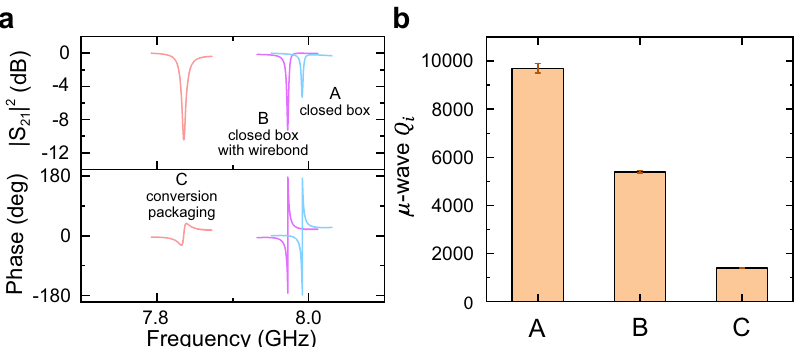
Fig. 5 Superconducting microwave cavity performance. a Microwave re fl ection spectrum of the device (A) in a closed copper box (B) in a closed copper box with wire bonds (C) packaged with fi ber-array for conversion measurement. b The fi tted intrinsic microwave quality factors. The error bars show the standard derivations of the